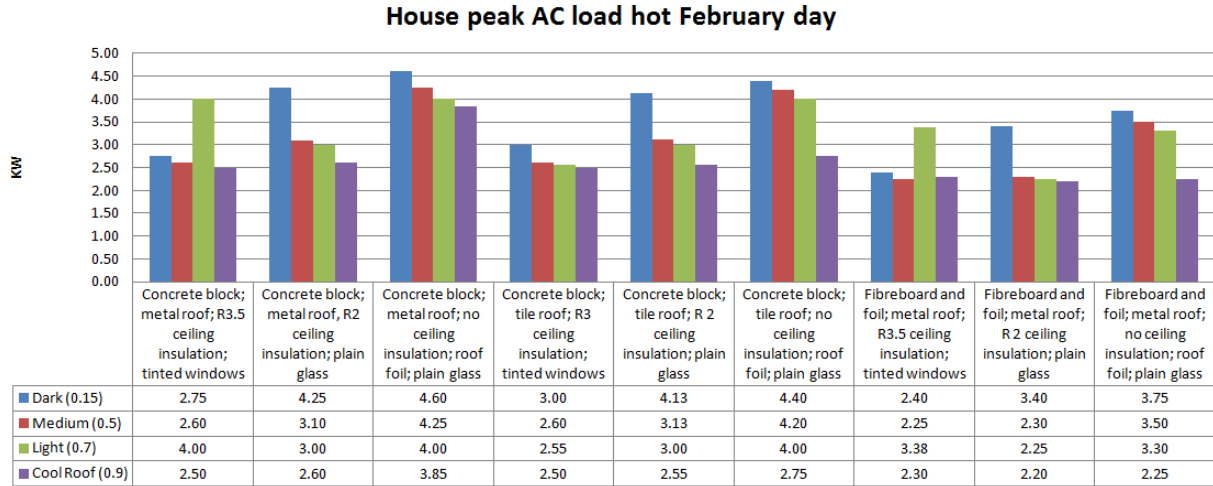
Figure 4. Simulated peak demand (kw) for 36 variations of the whole house on hot summer